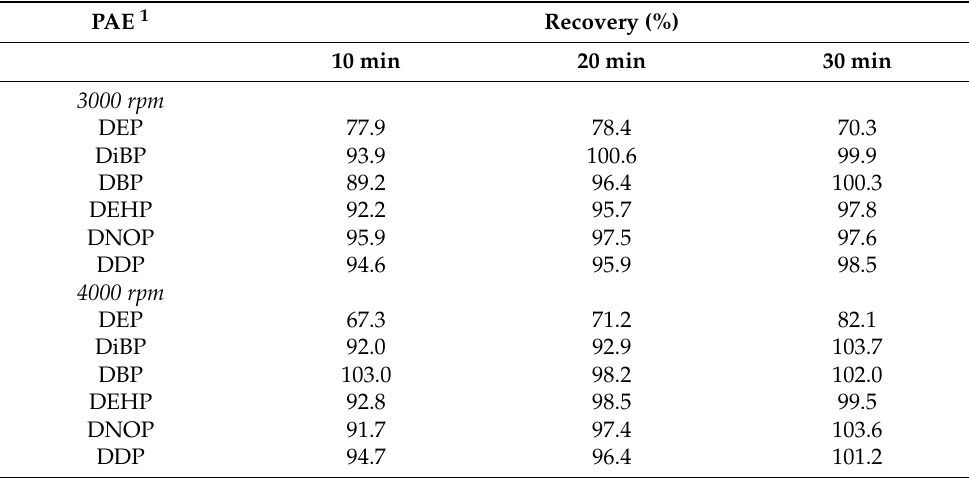
Table 5. Recoveries (%) obtained at 3500 and 4000 rpm at different times. PAE